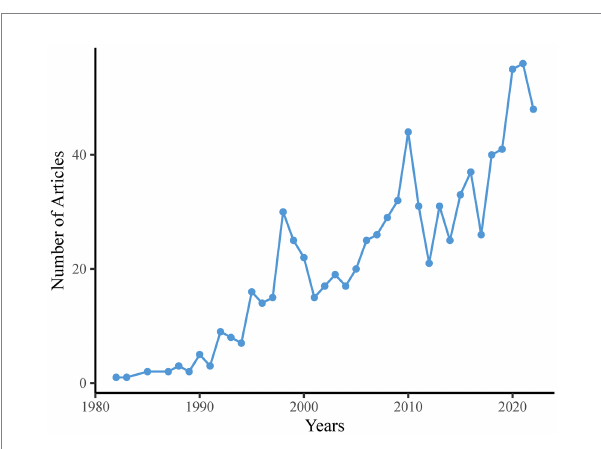
FIGURE 2 Scientific production of CEH-related literature between 1982 and